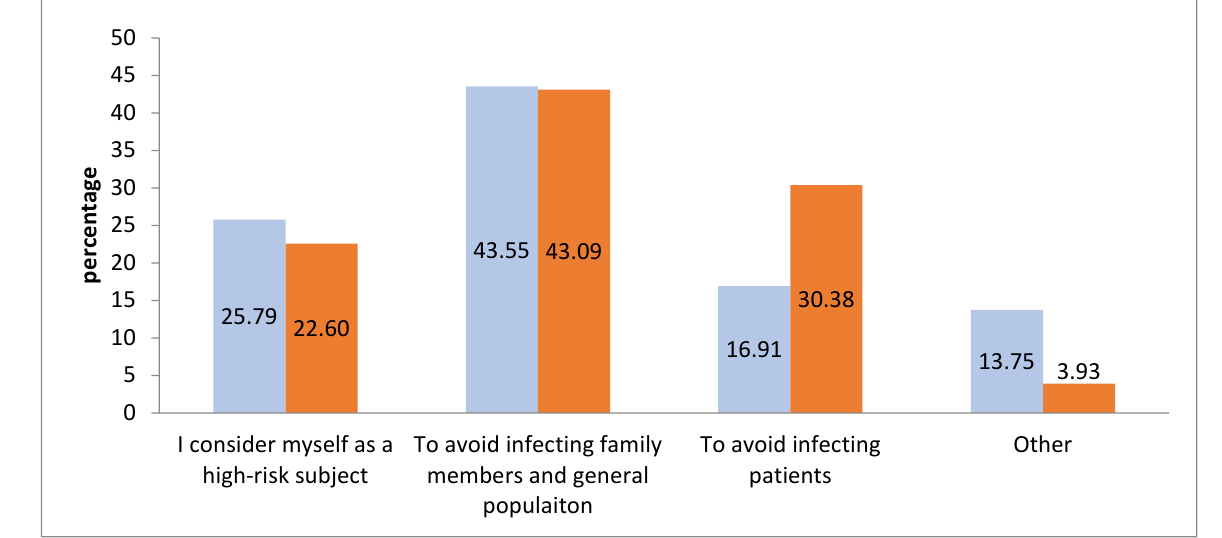
Figure 1. Comparing main reason for taking the vaccine the previous/following year. Used Pearson’s chi-squared test, chi-squared p -value < 0.001.